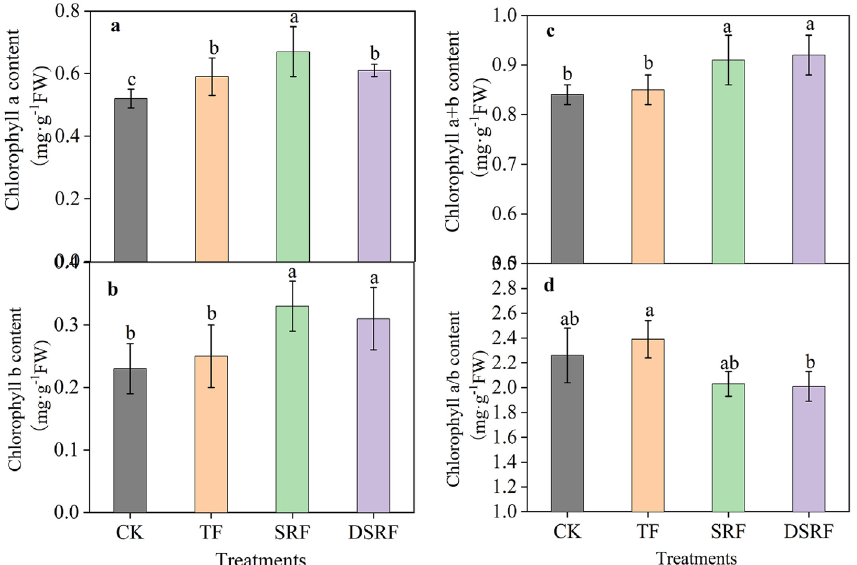
Figure 3. Chlorophyll a ( a ), chlorophyll b ( b ), chlorophyll a + b ( c ), and chlorophyll a/b ( d ) of wintering Chinese chives as affected by different fertilizer treatments. Lowercase letters indicate significant differences among different fertilization treatments ( p < 0.05). CK no fertilizer, TF traditional fertilization, SRF traditional fertilization with slow-release fertilizer, DSRF decreased fertilization with slow-release fertilizer.